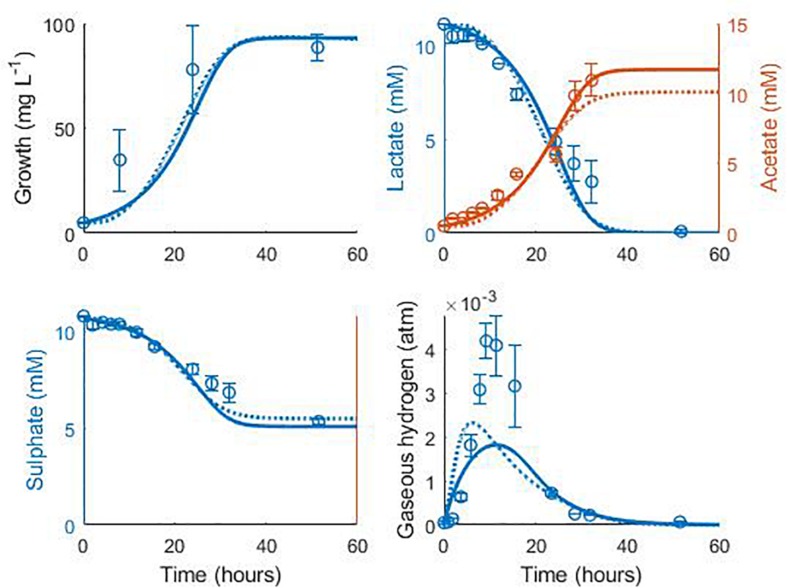
Model fits to data from Noguera et al. (1998): continuous lines display the fit of the current model; dotted lines display the fit of the model described in Noguera et al. (1998). Analysis of model fit is presented in Table 2.